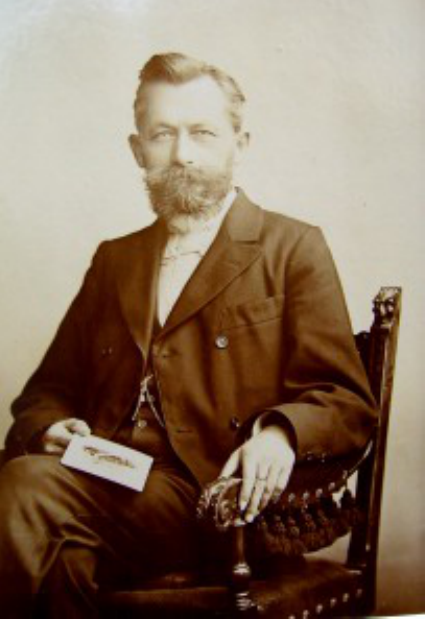
Figure 11. Max Eschenhagen’s portrait. Source: https: //geschichte.telegrafenberg.de/personen/eschenhagen-max/ (last access: 10 February 2023) – Helmholtz Centre Potsdam –